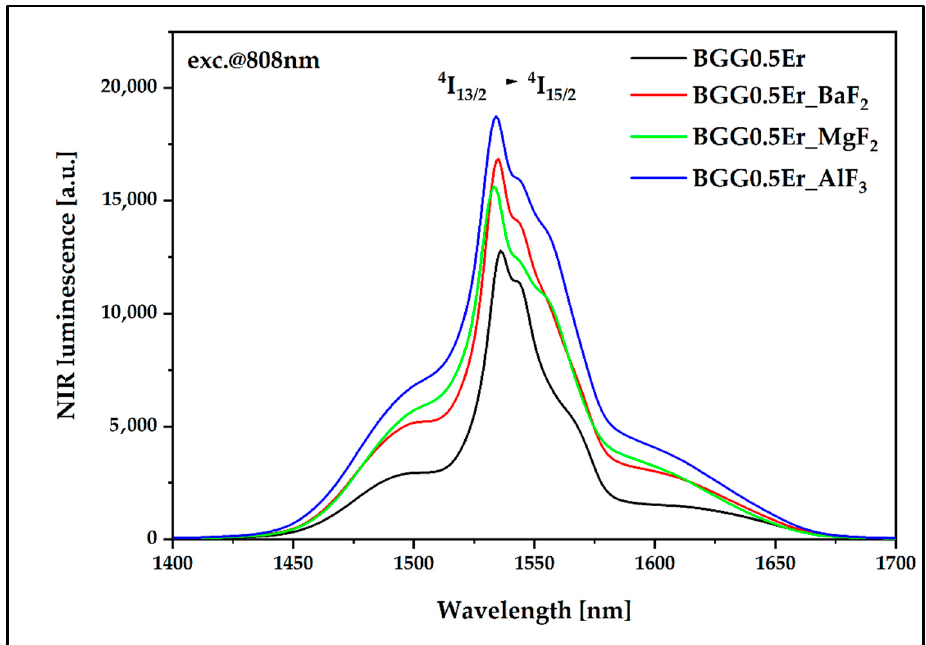
Figure 21. Luminescence spectra of Er 3+ -doped BGG glass modified by different fluoride compounds under 808 nm laser excitation in the 1400 – 1700 range.